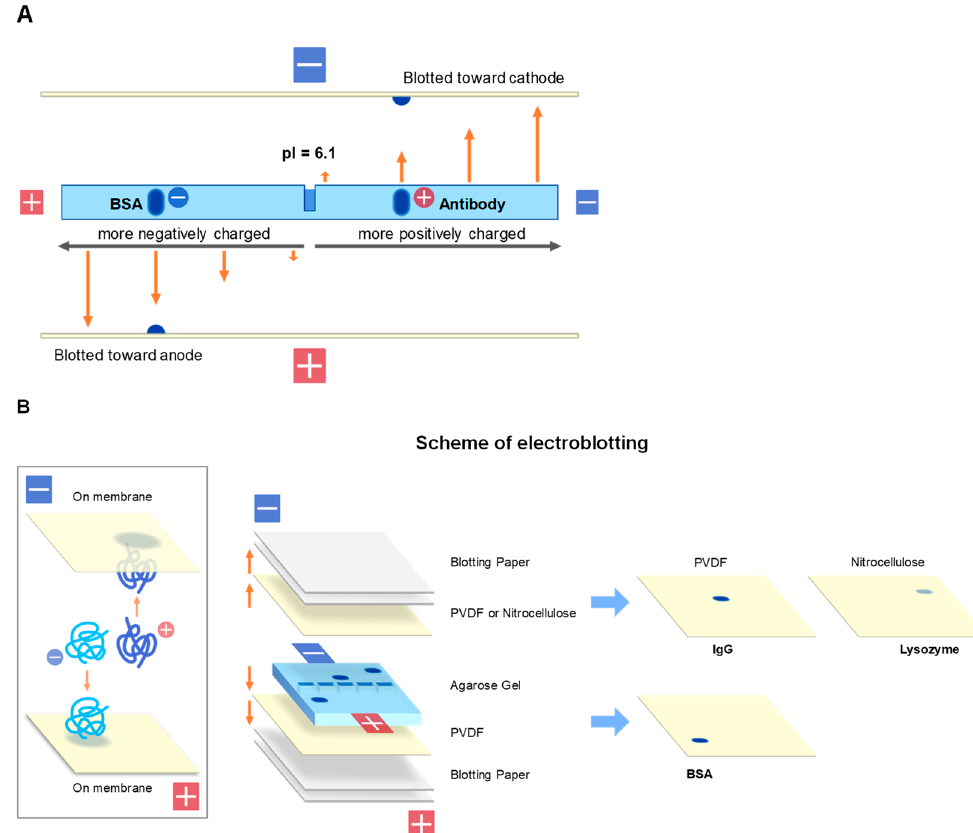
Figure 8. Schematic illustration of electroblotting from agarose gel. ( A ) Relationship between the net charges and direction and transfer efficiency in electroblotting. Indicated by arrows are hypothetical transfer efficiency due to the number of net charges. ( B ) Schematic illustration of native protein in blotting (inset) and actual setup of the blotting. Typically, electroblotting (semi-dry) was performed at a constant current of 1.5 mA/cm 2 for 30 min.